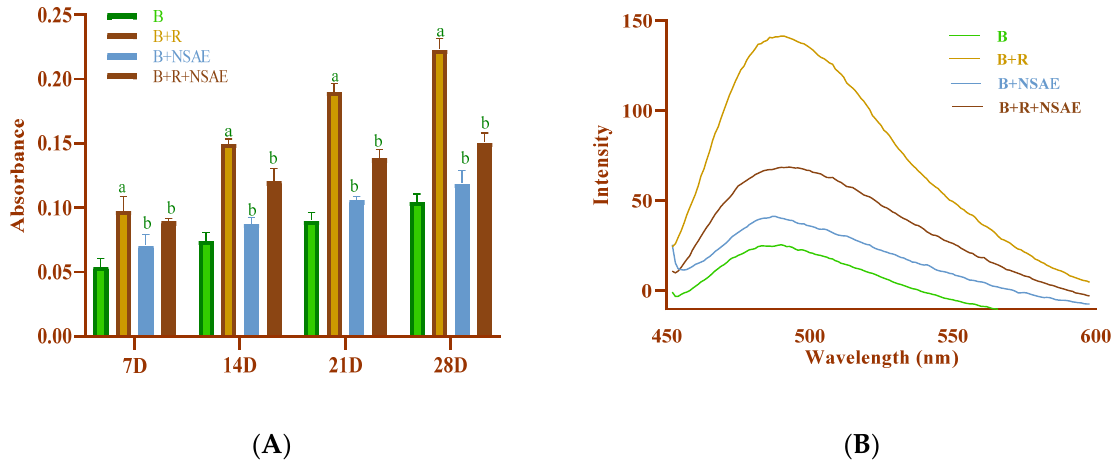
Figure 10. The effect of NSAE on the formation of amyloid cross β -structure using ( A ) Congo red assay and ( B ) Thioflavin T assay in BSA+D-ribose system. Results are represented as mean ± SD ( n = 5). a p < 0.05 when compared to BSA and b p < 0.05 when compared to BSA+D-ribose.